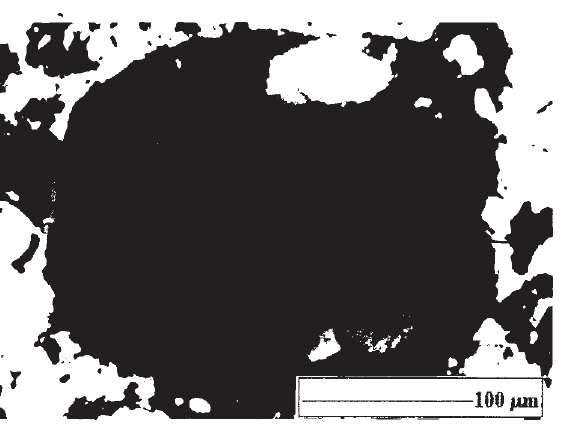
Figura 10. Macroagregados parcialmente destruídos no horizonte Ap do perfil com dois anos de cultivo